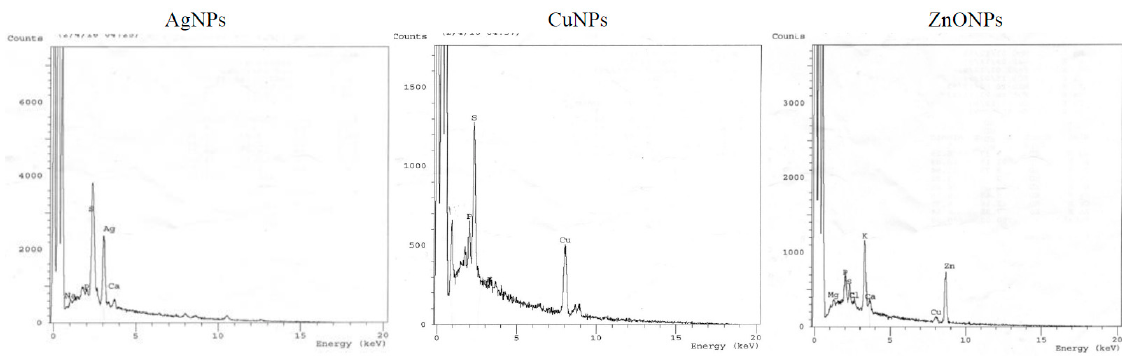
Figure 2. Energy dispersive X-ray microanalysis (EDX) of AgNPs, CuNPs, and ZnONPs synthesized using aqueous extract of Zingiber officinale .